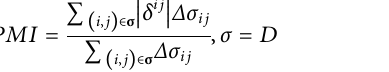
( Figure 2A ). Compared with the winter westerly wind fi eld, the wind fi eld of summer showed a signi fi cant change. Based on wind fi eld standardization seasonal variability ( Figure 2B ) de fi ned by Li and Zeng (2000), Zhang et al. (2015) de fi ned a TP monsoon index to re fl ect the seasonal changes in the TP wind fi eld. The formula is